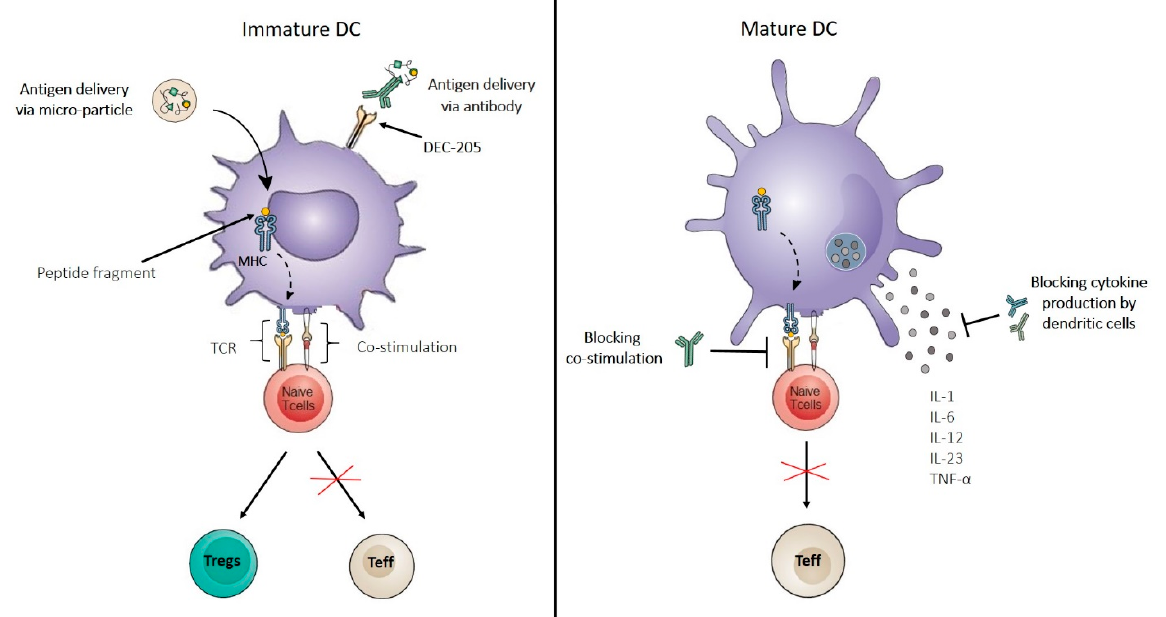
Figure 3. Dendritic-cell-targeted therapies for treating type 1 diabetes. Therapies targeting dendritic cells support the tolerogenic potential of dendritic cells. DCs can be made tolerogenic by targeted delivery of self-antigens by coupling them to antibodies raised against specific dendritic cell receptors, such as the DEC-205, or by targeted delivery via microparticles. Other potential therapeutic strategies aim to limit the immunogenicity of DCs by impeding their production of inflammatory cytokines or by reducing their expression levels of costimulatory molecules and, therefore, the induction of effector T cell responses. Most of these approaches implicate the usage of monoclonal antibodies, which target molecules that are selectively expressed by DCs. DEC-205, decalectin-205; MHC, major histocompatibility; TCR, T cell receptor; Tregs, regulatory T cells; Teff, T effector cells; IL, interleukin; TNF- α , tumor necrosis factor-alpha.